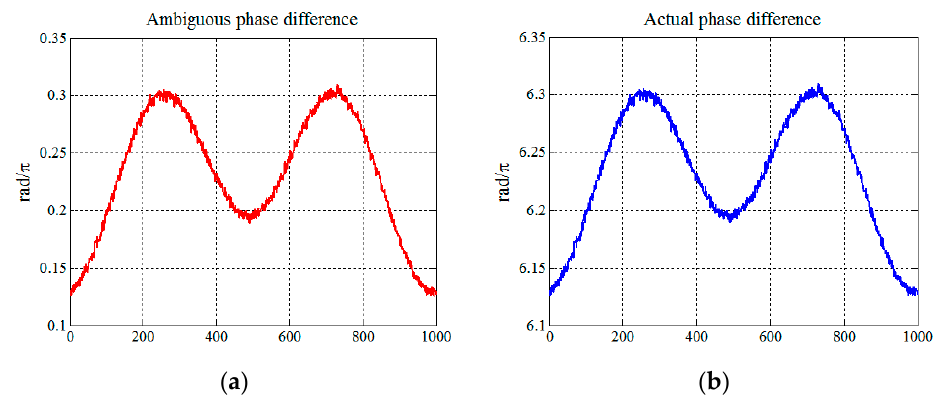
Figure 6. Measurement results: ( a ) Ambiguous phase difference of the echo signals from the receiving antennas A 1 and A 2 ; and ( b ) actual phase